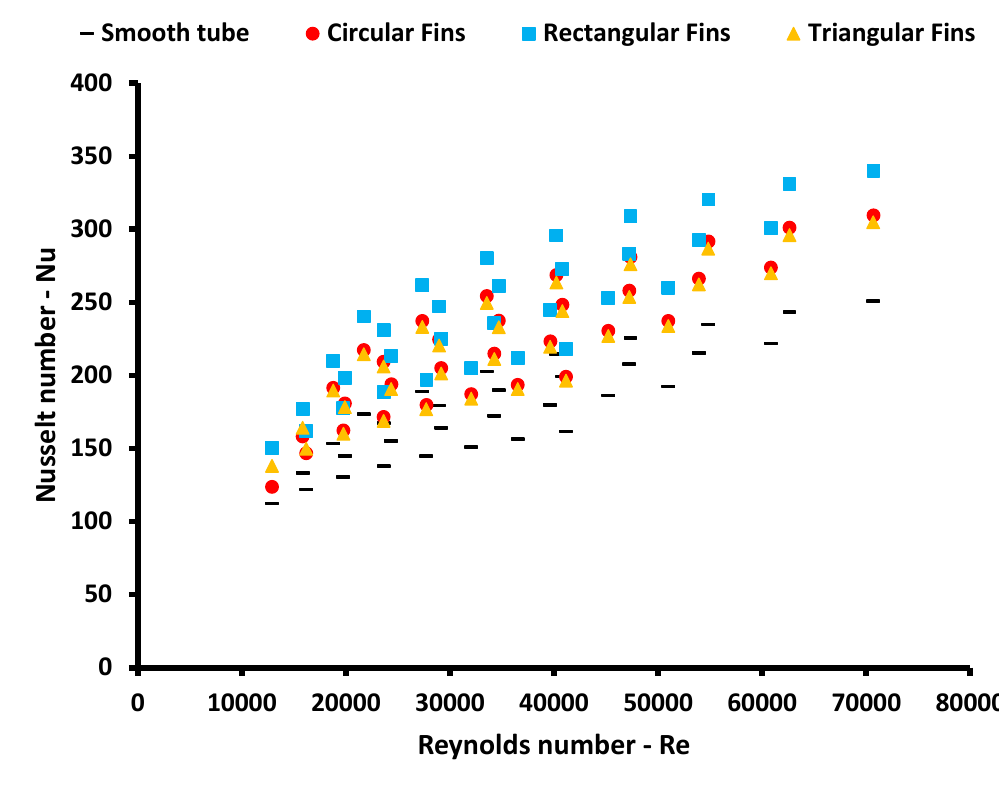
Figure 14. Nusselt number in the examined cases for all the tubes.